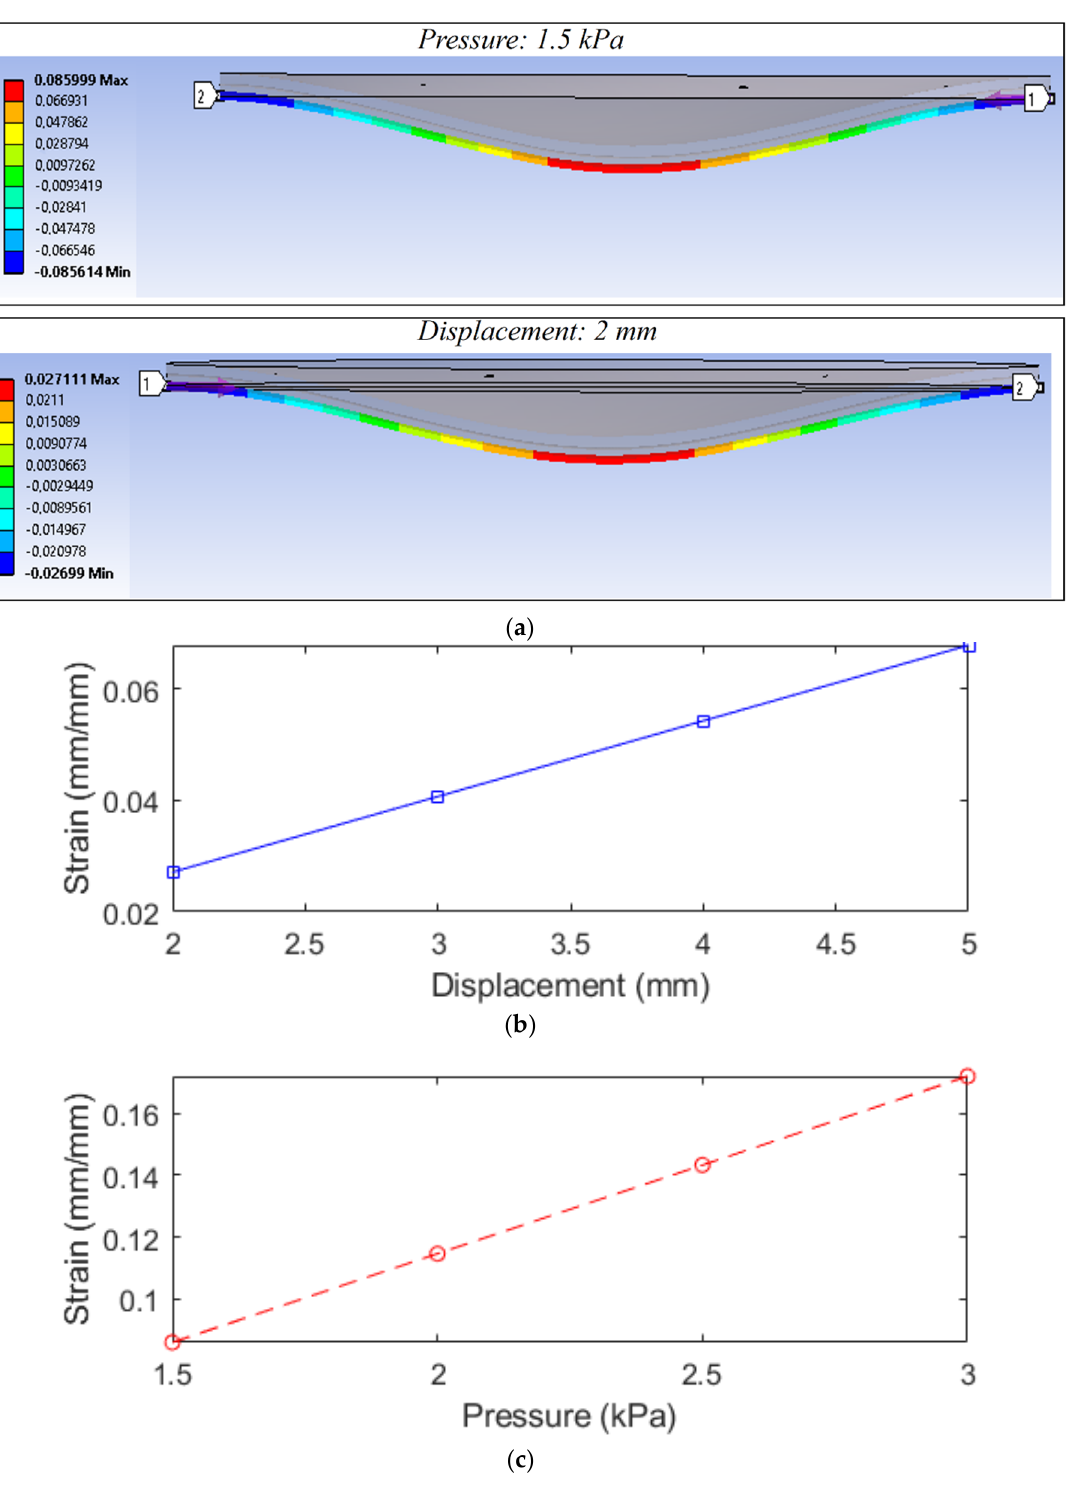
Figure 3. ( a ) FEM results. Strain in the optical fiber as a function of the ( b ) displacement and ( c ) pressure.